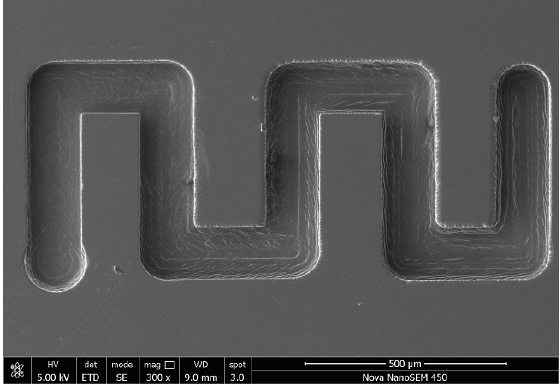
Figure 11. Complex micro channel on glass. Figure 1. Double immunofluorescence staining of rat liver sections (GdCl 3 treatment) with antibodies directed against ED-1 (green) and MPO (red) followed by fluorescence immunodetection. Liver sections from different time points of study are shown: control ( A ); 3 h ( B ) and 24 h ( C ). Results shown are representative pictures of six animals and six slides per time point. (Original magnification 200